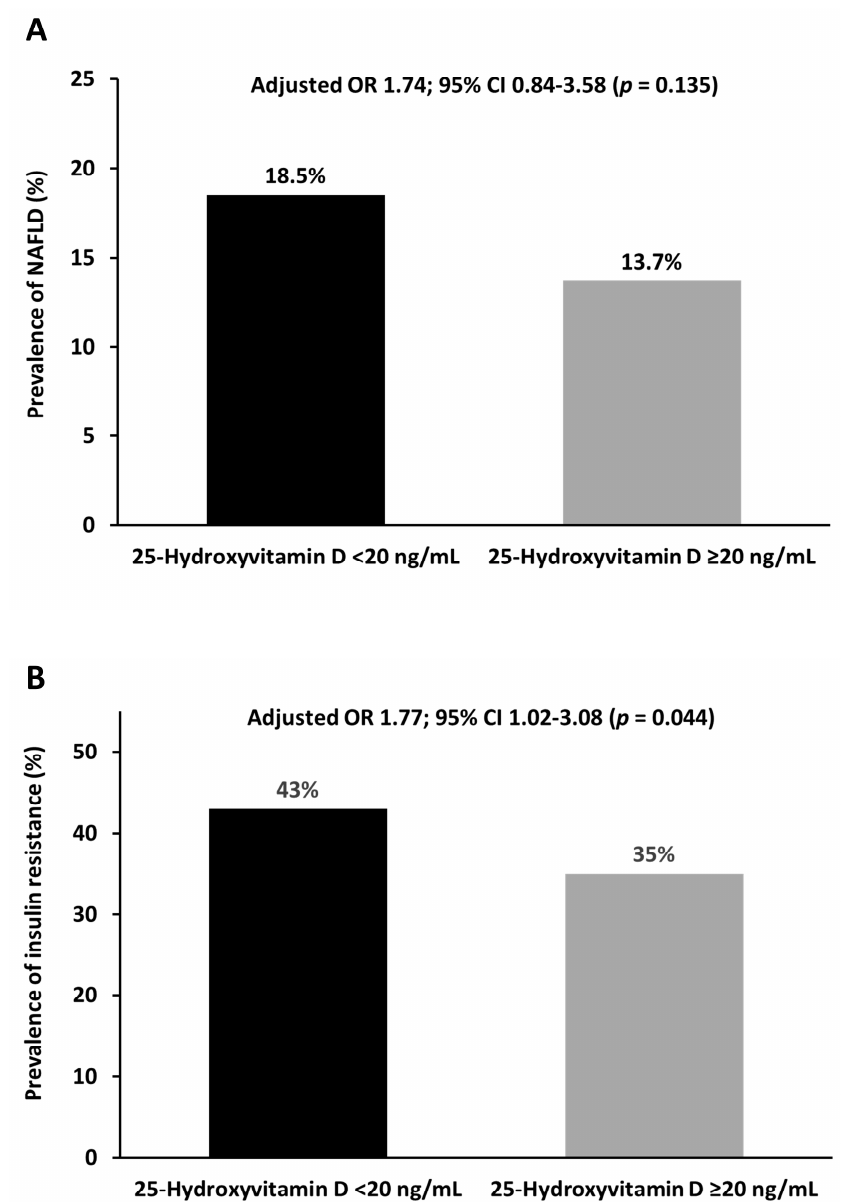
Figure 1. Adjusted odds ratio (OD) of vitamin D deficiency for ( A ) nonalcoholic fatty liver disease (NAFLD) and ( B ) insulin resistance after controlling for age, sex, healthcare profession, and daily calorie intake. Table 4. Unadjusted and adjusted odds ratio of dietary composition associated with insulin resistance.